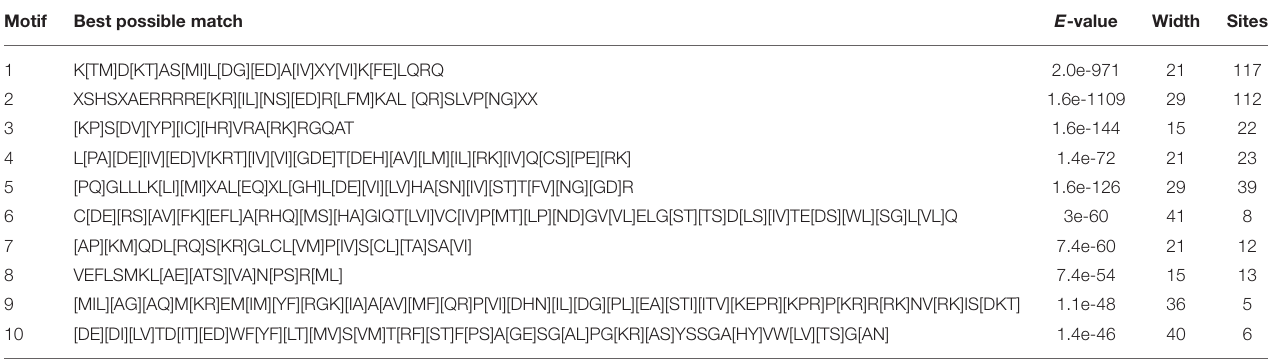
TABLE 1 | Sequences of 10 predicted motifs of FcbHLH